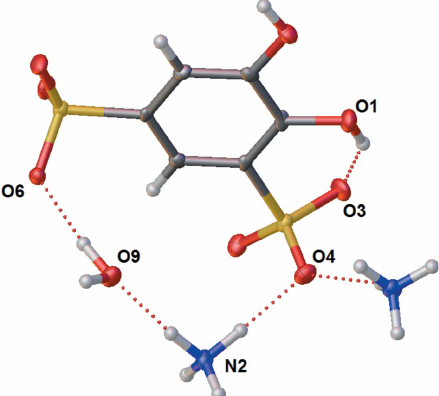
Figure 5 Displacement ellipsoid plot of asymmetric-unit contents for the crystal structure of (NH 4 ) 2 (tiron) (cid:2) H 2 O, showing intramolecular H-bonding with ammonium ions and solvate water. Ellipsoids shown at the 50% probability level. Hydrogen atoms shown as